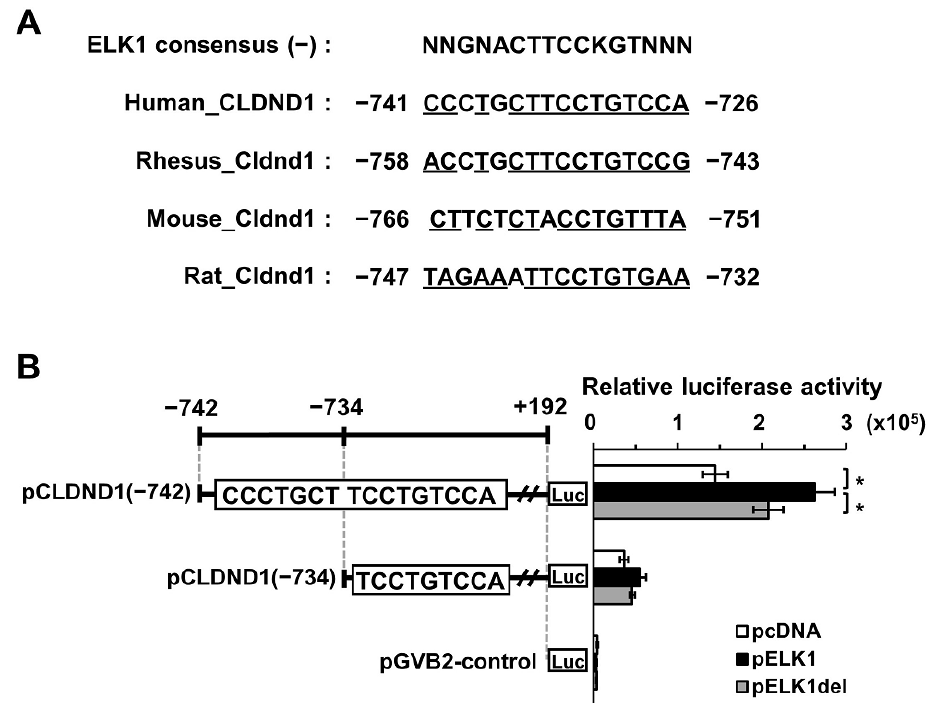
Figure 1. ELK1-binding sites in the CLDND1 promoter region. ( A ) Sequences of putative ELK1-binding sites in humans, rhesus monkeys, mice, and rats. Common sequences that are conserved among species are underlined. ( B ) HBECs were co-transfected with luciferase reporter vectors linked to the fragment regions – 742 to +192 (pCLDND1( – 742), with an enhancer) or – 734 to +192 (pCLDND1( – 734), without an enhancer), and empty (pcDNA), or ELK1-expressing (pELK1) or ELK1 deletion mutant-expressing (pELK1del) vectors, respectively. Results are expressed as mean ± SE, n = 3, * p < 0.05.